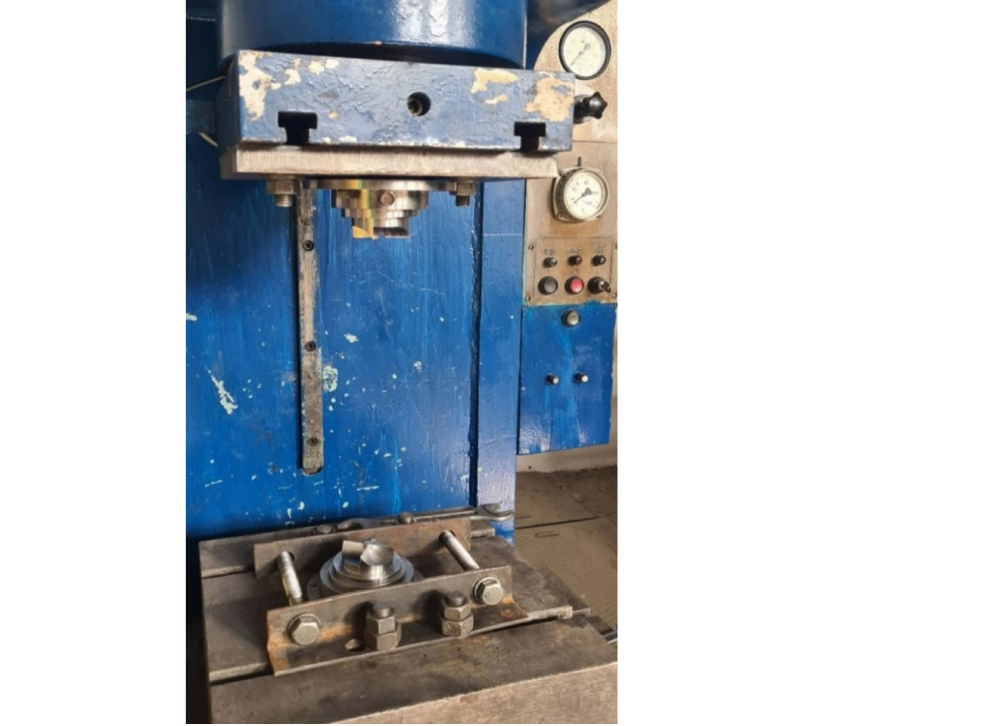
Figure 2. Structure assembly.